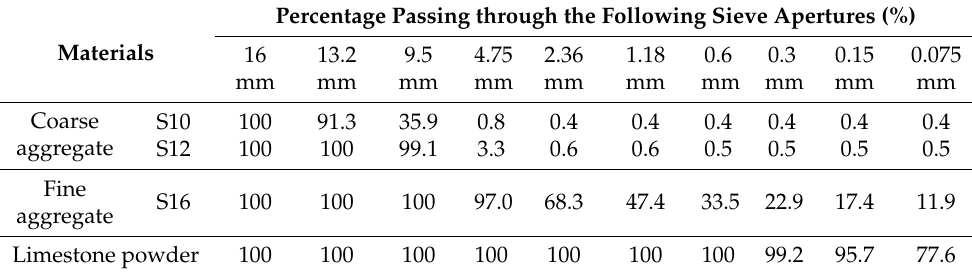
Table 5. Screening results of aggregates and filler